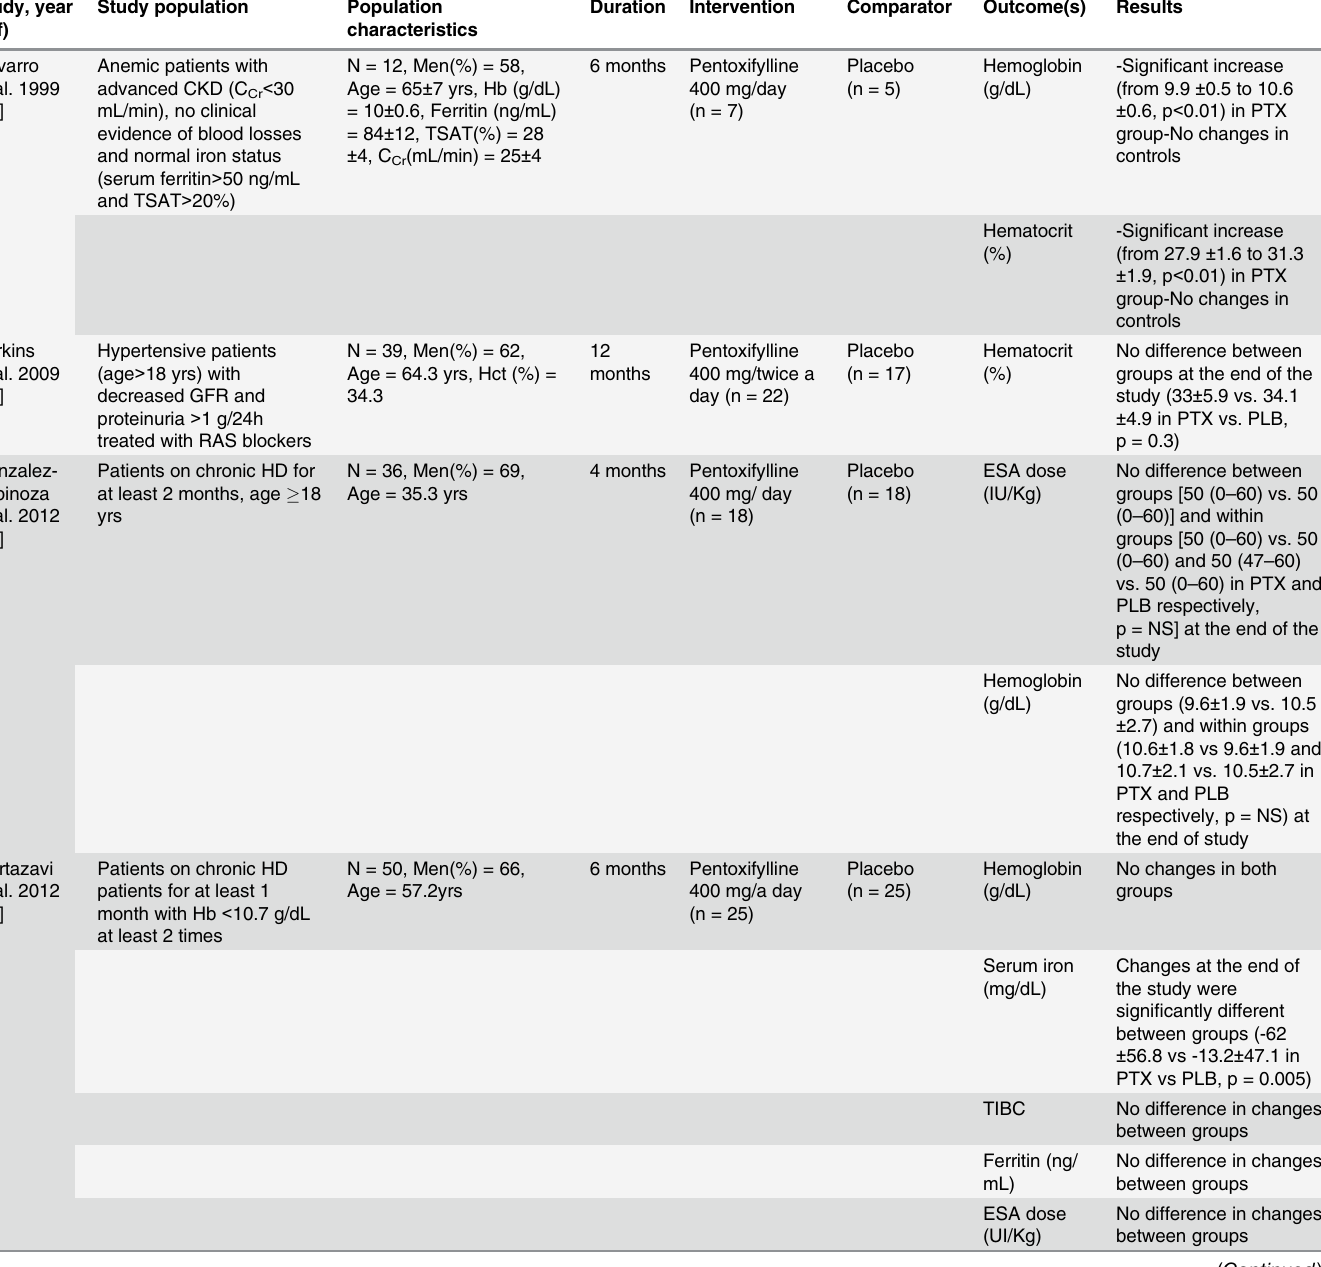
Table 2. Summary of the main characteristics of the randomized studies